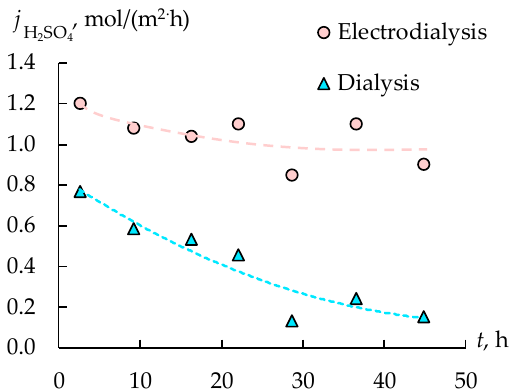
Figure 10. The current density and voltage drop on the electrodialyzer during the second stage.